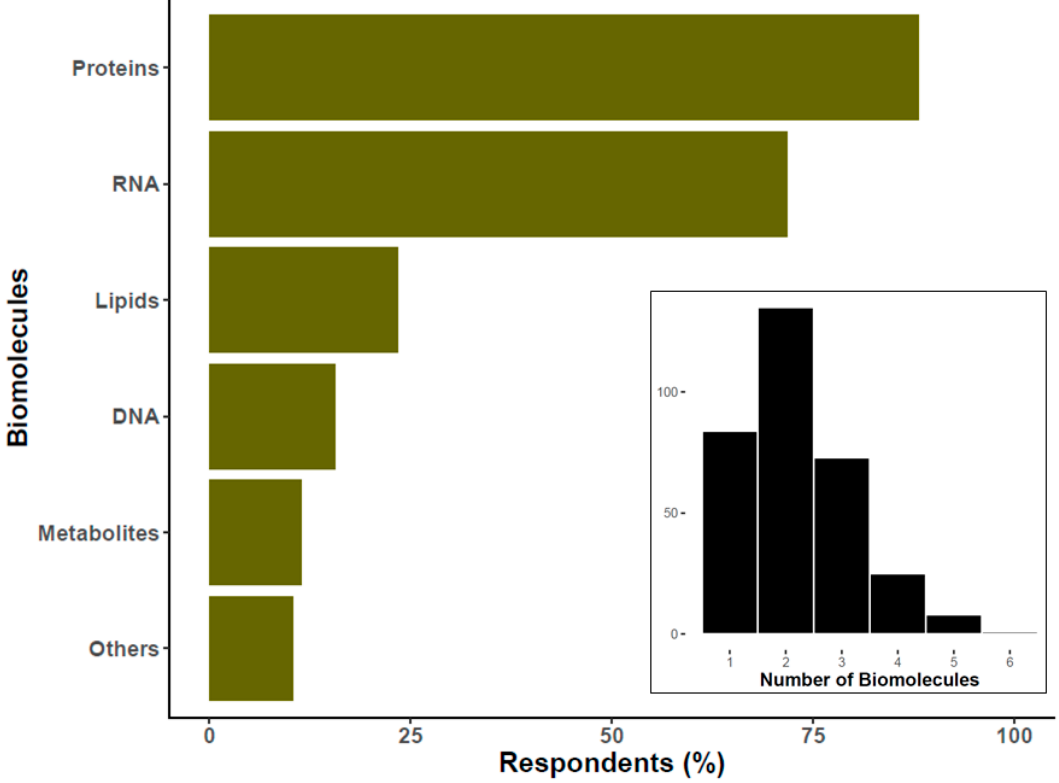
Figure 5. Percentage of researchers interested in specific types of EV-associated biomolecules. The histogram at the bottom of the graph reflects the number of researchers ( Y -axis) that study the specified number of biomolecule classes ( X -axis). For the main graph, the percentage was calculated over 326 respondents. Please note that this question had the possibility of multiple answers.